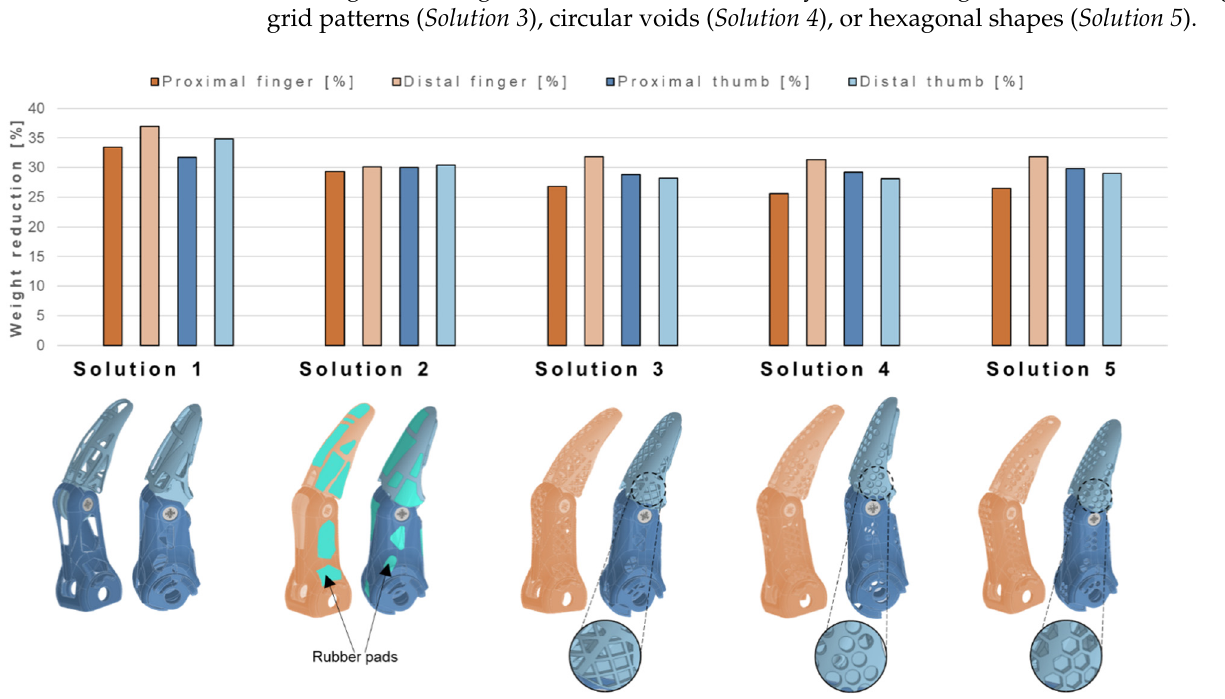
Figure 9. Weight reduction as a percentage of the obsolete component weight for proximal and distal finger and thumb of the novel-designed five solutions. On the bottom part of the image, a schematic of each solution is reported, with a zoom on their specific peculiarities (geometrical patterns).